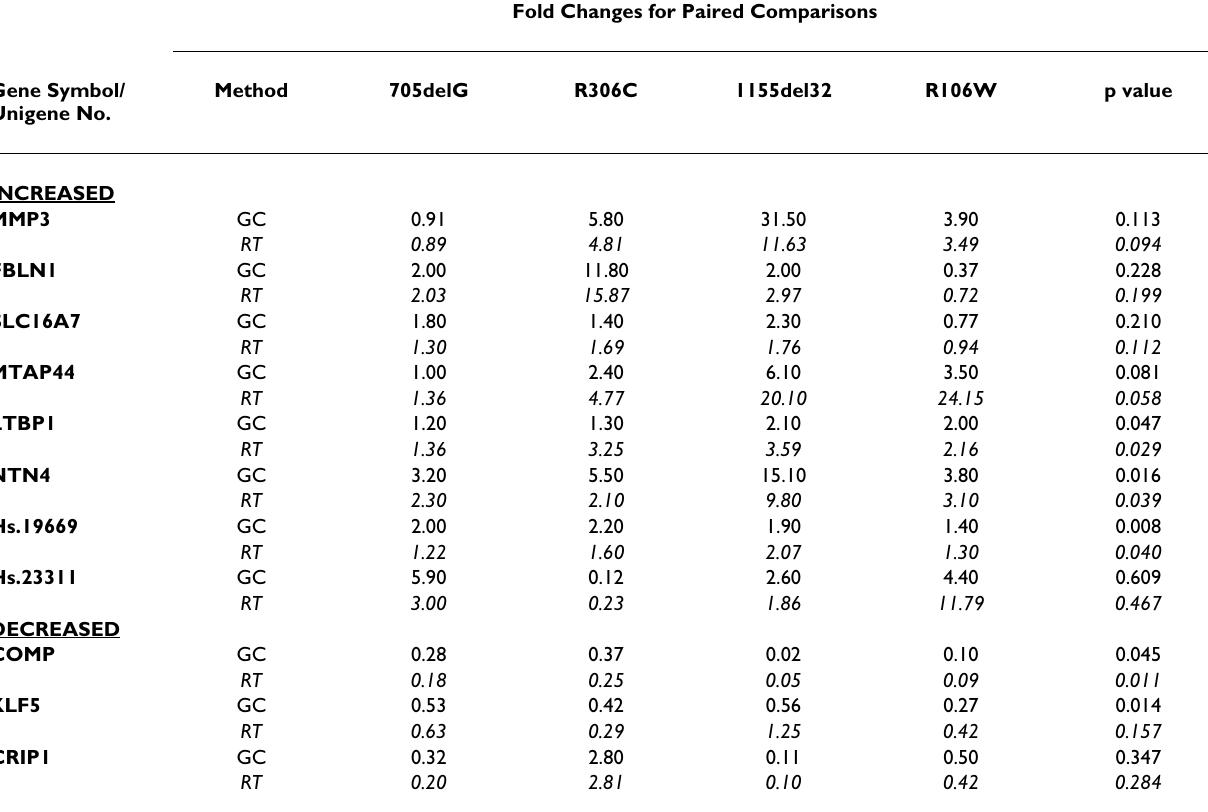
Table 3: Comparisons of GeneChip ® and RT-PCR expression fold changes in mutant versus wild-type MECP2 expressing clones for 11 differentially expressed genes Fold Changes for Paired Comparisons